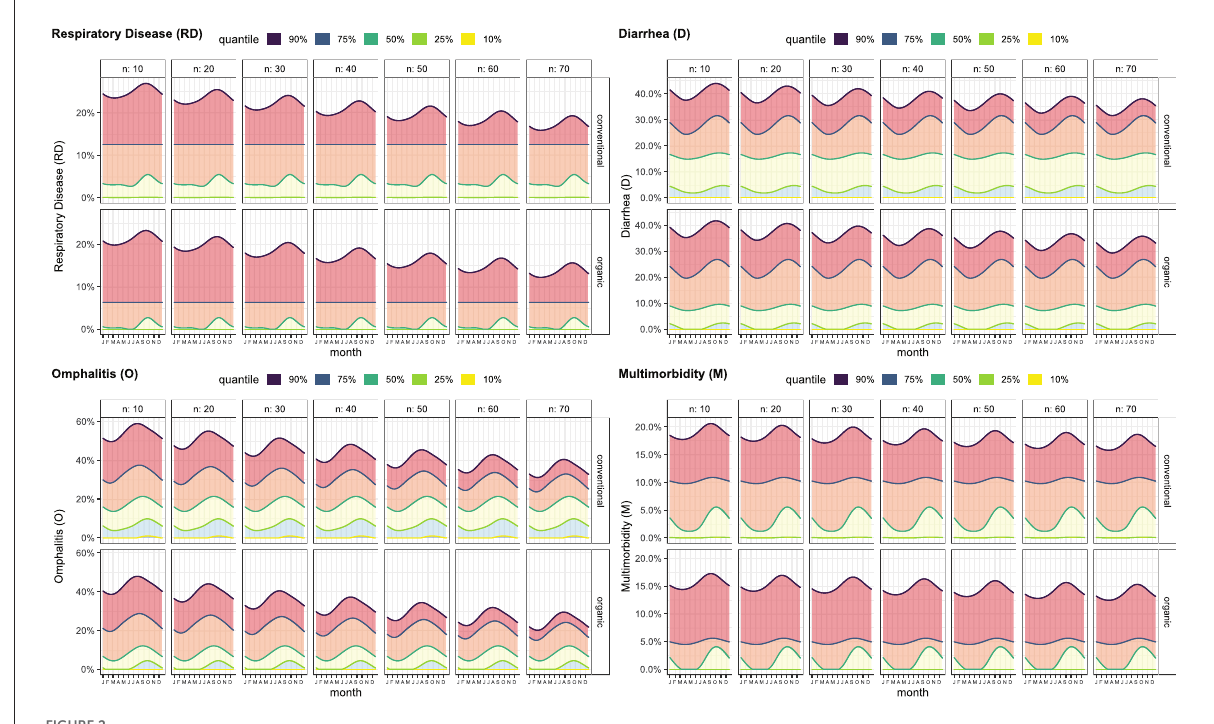
FIGURE2 Prevalence of disorders based on number of preweaned dairy calves examined at the day of the farm visit for conventional and organic managed dairy farms depending on day of year/month. Quantile functions were estimated using a quantile non-parametric additive model (qgam) for 10, 25, 50, 75, and 90% quantiles. A continuous effect was estimated using restricted splines for number of calves and day of year (circular). Exemplary values are shown for the number of calves ( n = 10, n = 20, n = 30, etc.). The farm type (organic, conventional) effect was estimated as a factor. These functions form the basis for the calf health